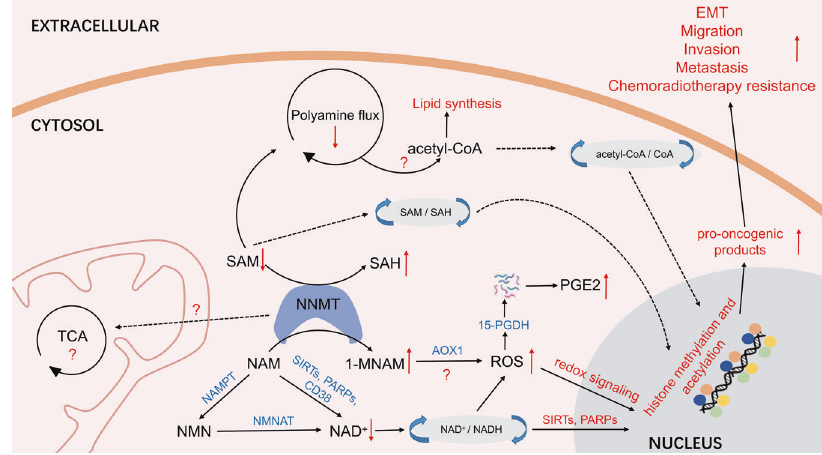
Fig. 6 Possible mechanisms of NNMT-promoted malignant progression of some tumors. High expression of NNMT may contribute to the downregulation of SAM, NAM, and NAD + levels. The reduction of SAM may lead to the accumulation of acetyl-CoA for lipid synthesis in some types of tumors. Then the changes of SAM and acetyl-CoA may trigger the epigenetics remodeling and affect gene expression, which brings about the production of pro-tumor products. On the other hand, the decline of NAM and NAD + may increase ROS and in fl uence enzymes activities like SIRTs and PARPs through a switch between NAD + and NADH. Oxidative stress results in the degradation of 15-PGDH and accumulation of PGE2, an important pro-in fl ammatory and immunosuppressive factor. These changes may eventually promote EMT, migration, invasion, metastasis, and chemoradiotherapy resistance. Inexplicably, the product of NNMT catalyzed reaction, 1-MNAM, is a bioactive molecule but now we know little about it. 1-MANM may have target proteins or pathways and play roles in tumors. Question marks mean that the mechanisms of corresponding pathways are still